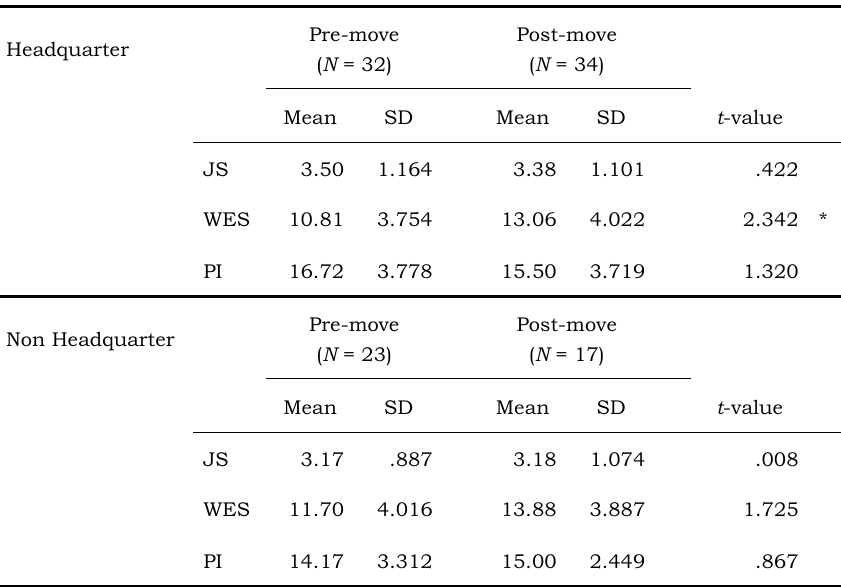
Table 2. Comparison between pre-move and post-move survey